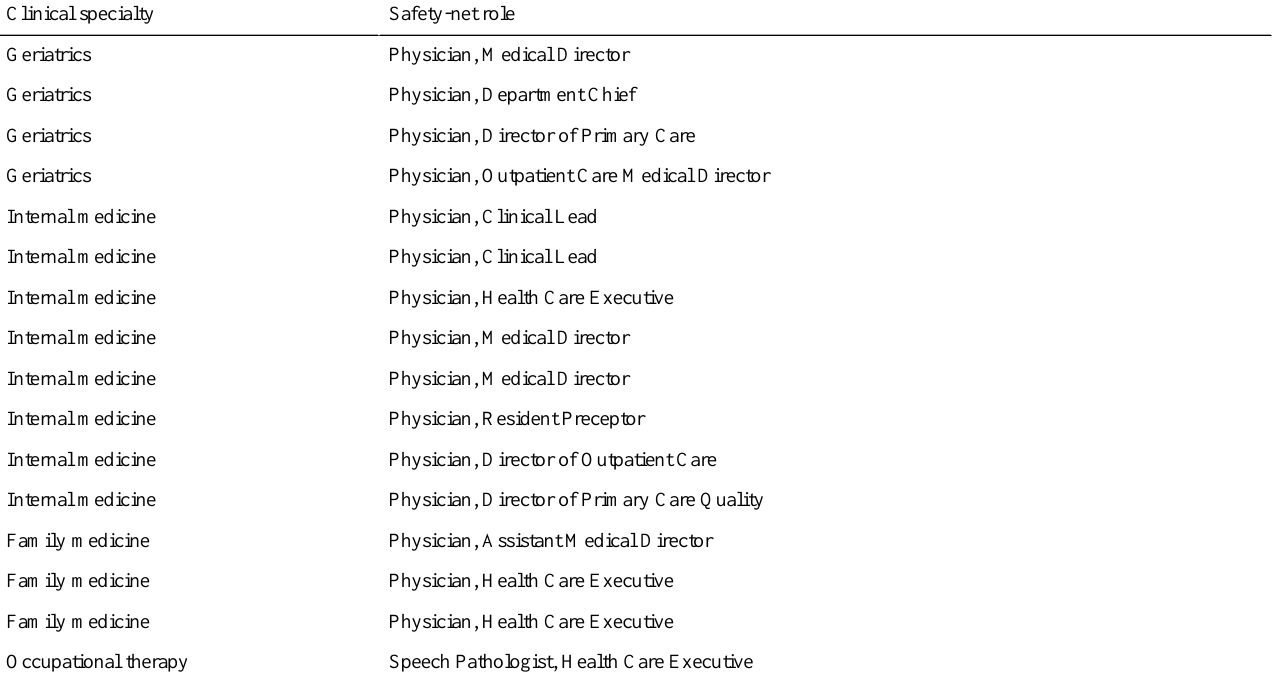
Table 1. Safety-net provider